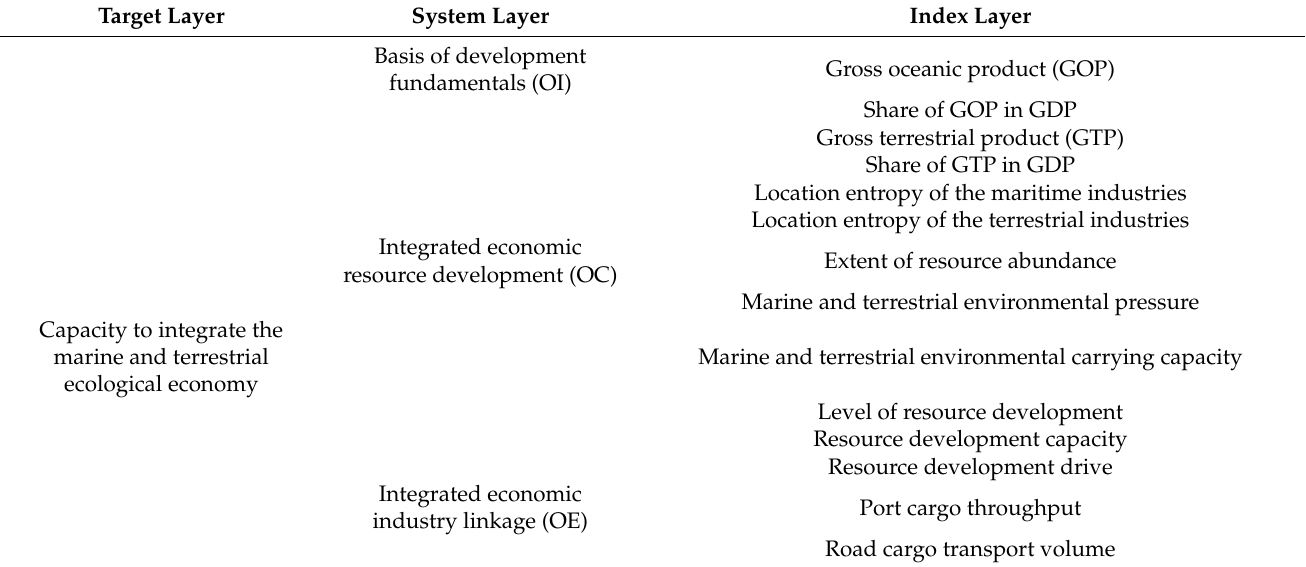
Table 1. System for assessing the development of a city’s capacity to integrate its marine and terrestrial ecological economies. Source: the data sources used in this study include the 2010–2020 editions of the China Marine Statistical Yearbook, China City Statistical Yearbook, Shandong Statistical Yearbook, Liaoning Statistical Yearbook, Hebei Economic Yearbook, Tianjin Statistical Yearbook, Bulletin on Environmental Quality of China’s coastal waters, and the statistical bulletins of the relevant national